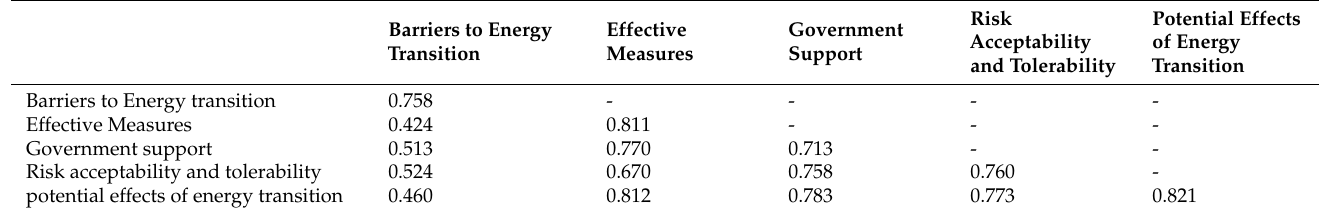
Table 3. Discriminant